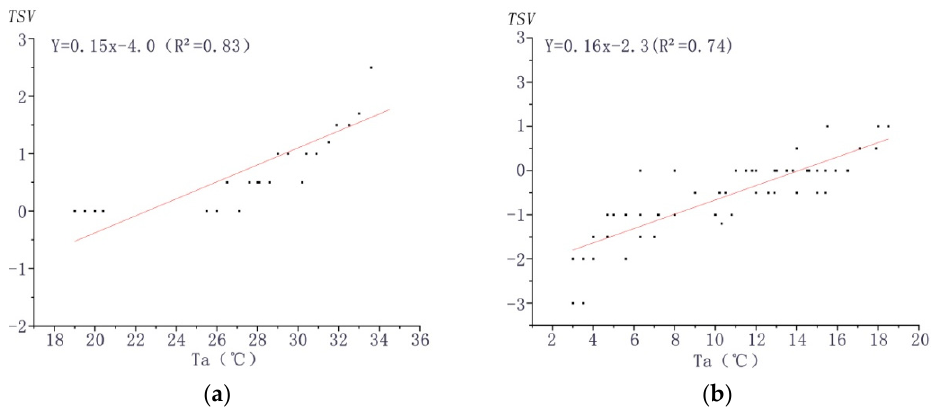
Figure 24. Distribution of TSV: ( a ) summer; ( b ) winter.